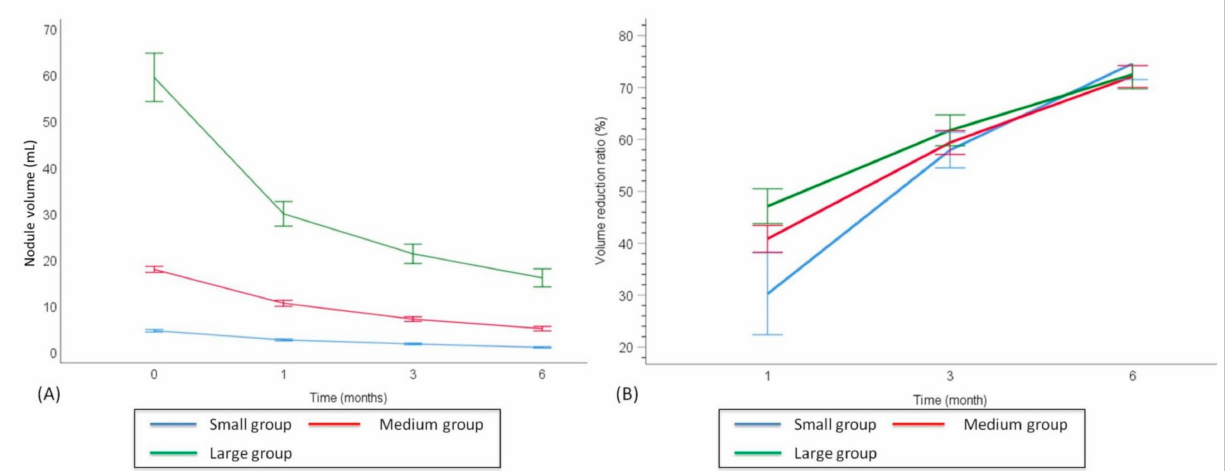
Figure 3. Follow-up changes in nodular volume and VRR of the three groups of BTNs. Changes in nodular volume ( A ) and VRR ( B ) of the different echogenicity groups of BTNs at each follow-up. BTN: benign thyroid nodule; VRR: volume reduction